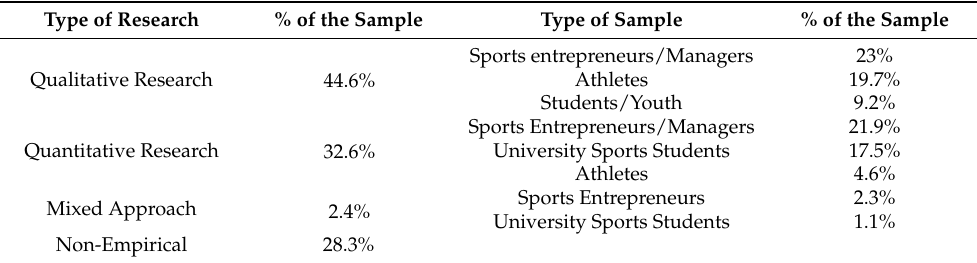
Table 3. Nature of research and type of